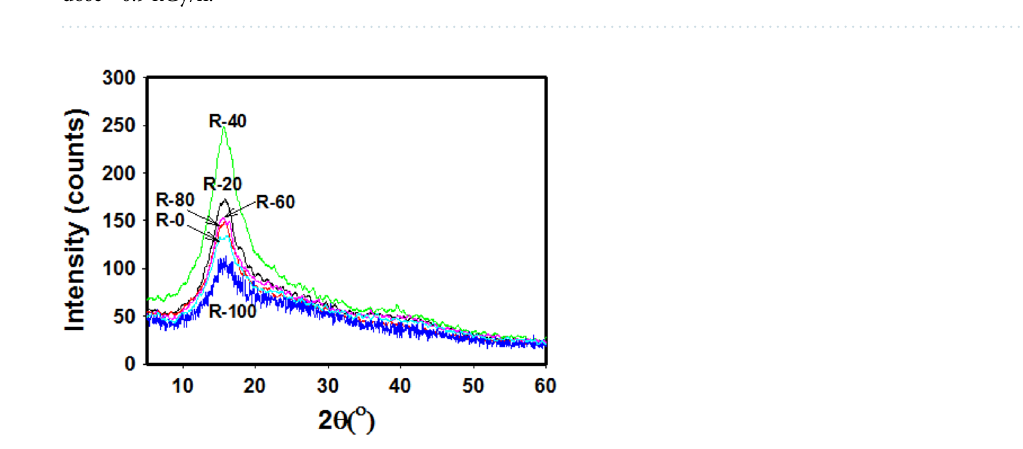
Figure 4. TGA thermographs of R-0, R-20, R-40, R-60, R-80 and R-100 samples with fixed rate of dose ~ 0.9 kGy/h.